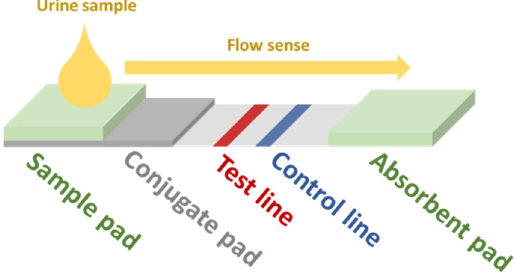
Figure 2. Scheme of a generic lateral-flow immunoassay paper-based sensor. Redrawn from Hainsworth et al. [19].